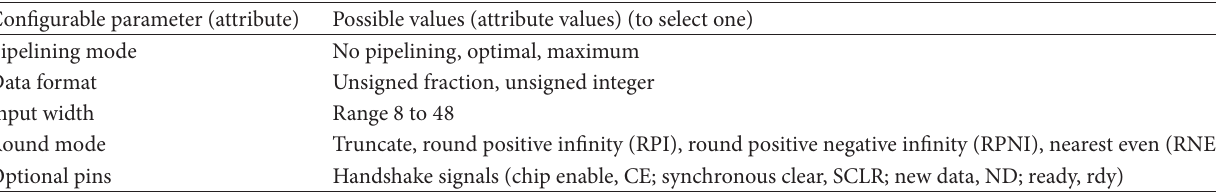
Table 12: Available configurable parameters for Xilinx CORDIC IP core implementing sqrt() function.